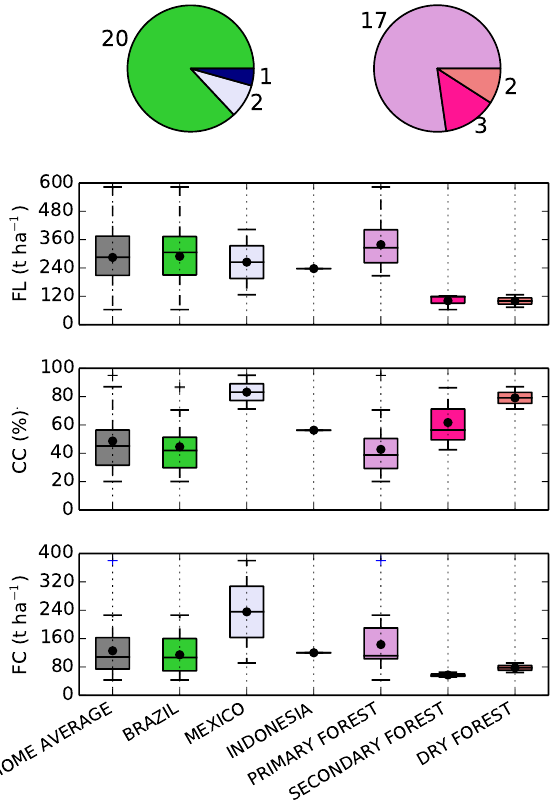
Figure 2. Overview of field measurements of fuel load (FL), com- bustion completeness (CC), and fuel consumption (FC) in the sa- vanna biome. The pie charts on top correspond to the number of unique measurement locations for different geographical regions (left) and savanna types (right), and in the box plots below field averages of FL, CC, and FC are presented. The boxes extend from the lower to upper quartile values of the measurement data, with a line at the median and a black filled circle at the mean. The whiskers extend from the box to show the range of the data, and outliers are indicated with pluses.